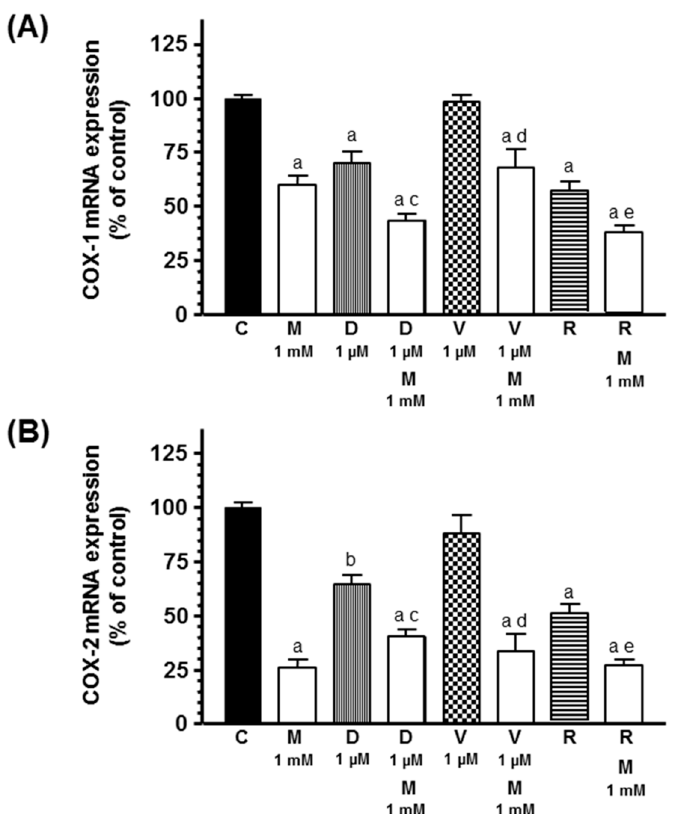
Figure 10. Effectsofmelatoninondocetaxel-,vinorelbine-,andradiation-inducedchangesoncyclooxygenases Figure 10. Effects of melatonin on docetaxel-, vinorelbine-, and radiation-induced changes on (COX) mRNA expression: ( A ) COX-1 and ( B ) COX-2. Data are expressed as the percentage of control group cyclooxygenases (COX) mRNA expression: (A) COX-1 and (B) COX-2. Data are expressed as the (mean ± SEM). a, p < 0.001 vs. C; b, p < 0.01 vs. C; c, p < 0.05 vs. D (1 µ M); d, p < 0.001 vs. V (1 µ M); e, p < 0.05 percentage of control group (mean ± SEM). a, p < 0.001 vs. C; b, p < 0.01 vs. C; c, p < 0.05 vs. D (1 µM); vs. R. C: control, M: melatonin, D: docetaxel, V: vinorelbine, R: d, p < 0.001 vs. V (1 µM); e, p < 0.05 vs. R. C: control, M: melatonin, D: docetaxel, V: vinorelbine, R: radiation.